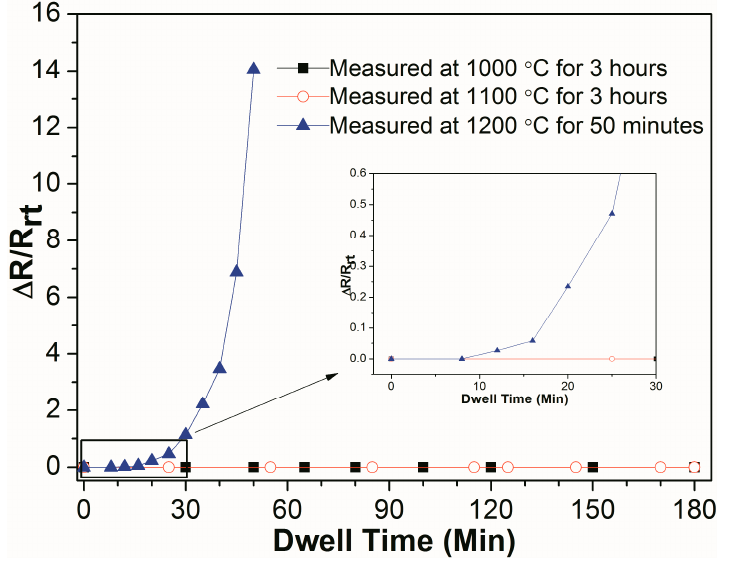
Figure 7. Relative resistance change of Al 2 O 3 /Pt/ZnO/Al 2 O 3 /LGS sample as a function of dwell time at 1000, 1100, and 1200 °C. The inset shows the enlarged figure of the relative resistance change curves before 30 min.